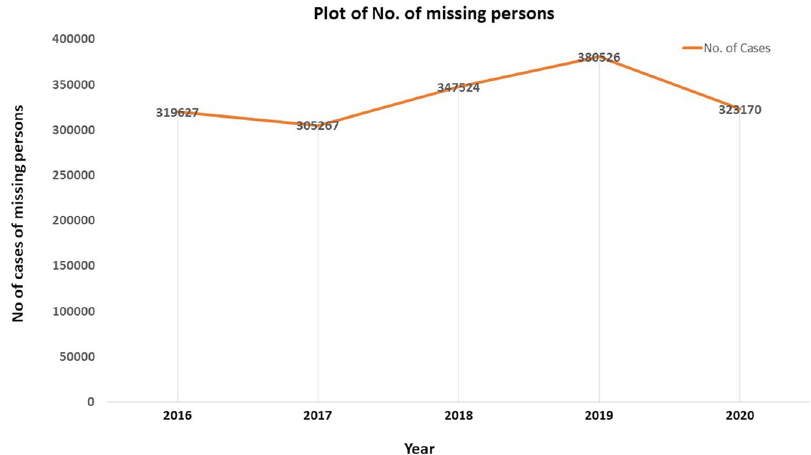
Fig. 1 Plot of the number of missing person cases in India during the years 2016 – 2020. x -axis: year. y -axis: number of cases of missing persons. Source: National Crime Records Bureau,